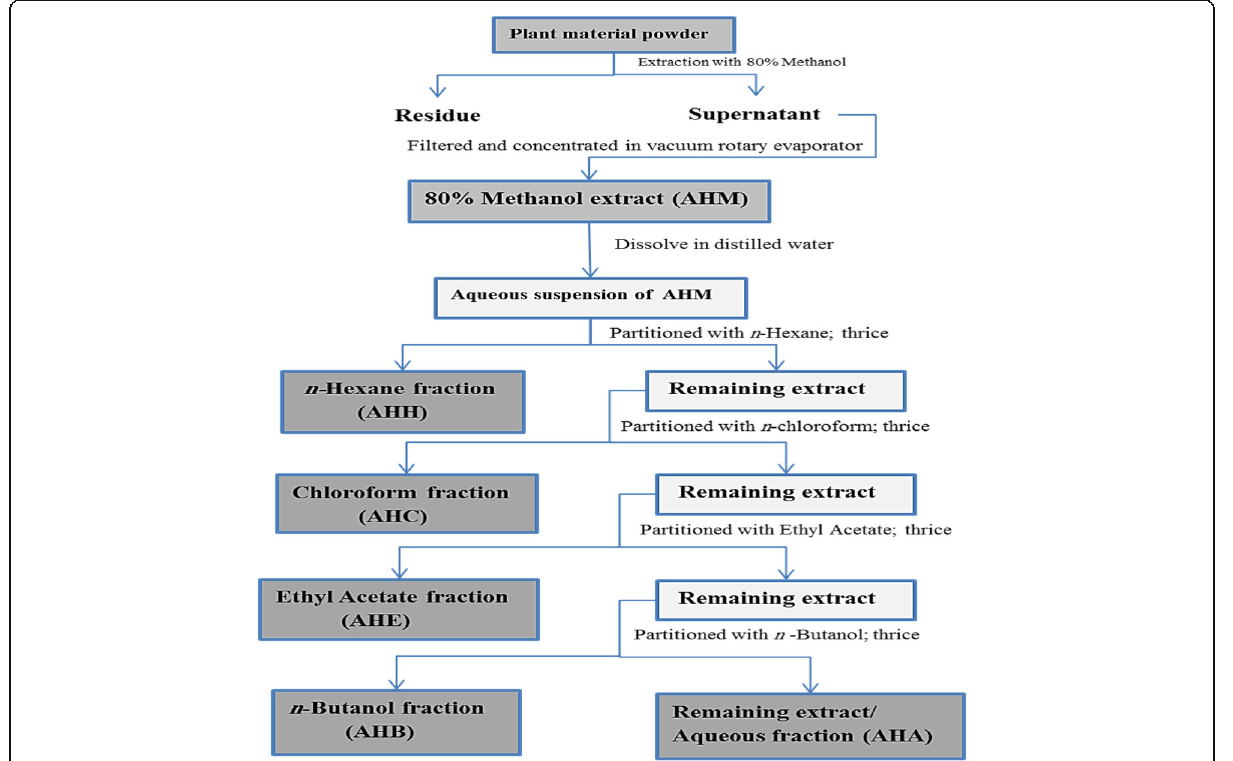
Fig. 1 Flow chart describing the extraction procedure for fractionation of A.